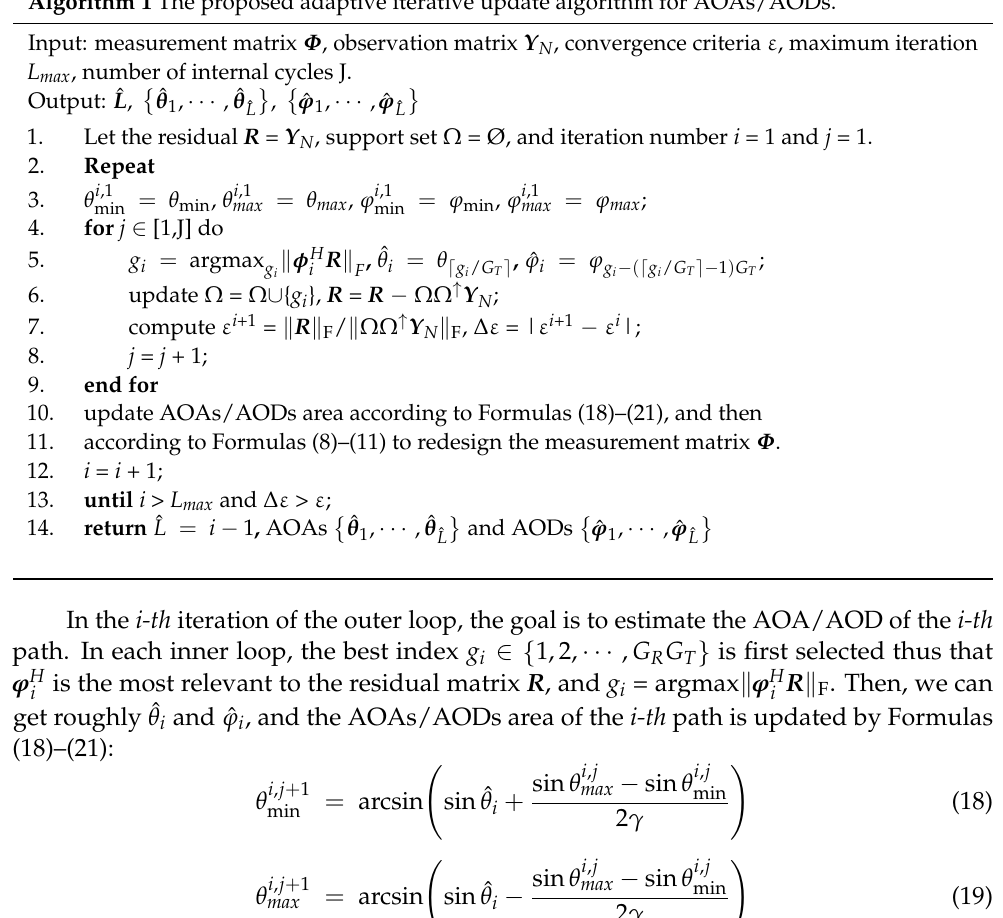
Algorithm 1 The proposed adaptive iterative update algorithm for